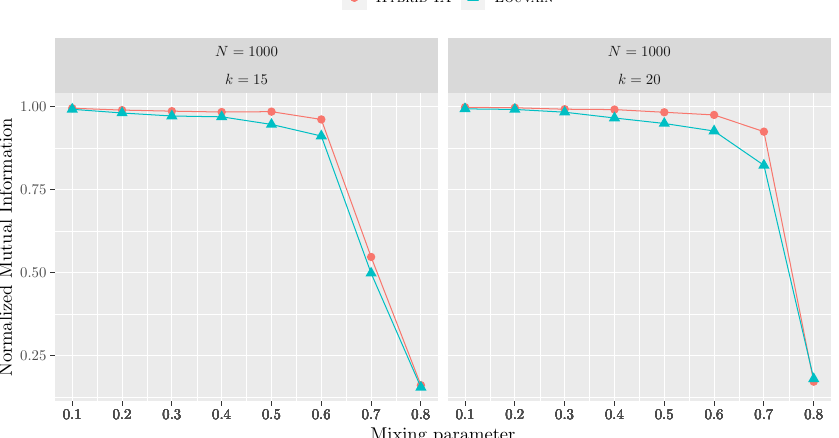
Figure 8. Performances of H YBRID -IA and L OUVAIN on the LFR instances with 1000 nodes and average degrees 15 and 20. The plots show the normalized mutual information as a function of the mixing parameter. Each point corresponds to an average over 5 produced graphs and 100